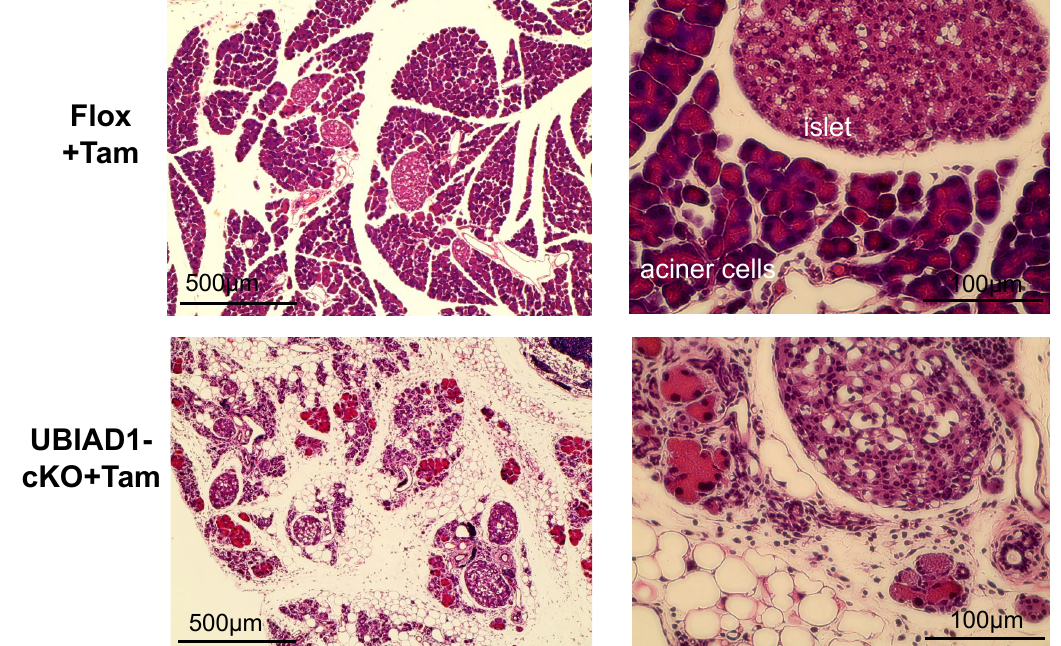
Figure 3. Hematoxylin–eosin (H&E)-stained pancreas sections from female Flox and UBIAD1-cKO mice at 40 days after administration of tamoxifen.